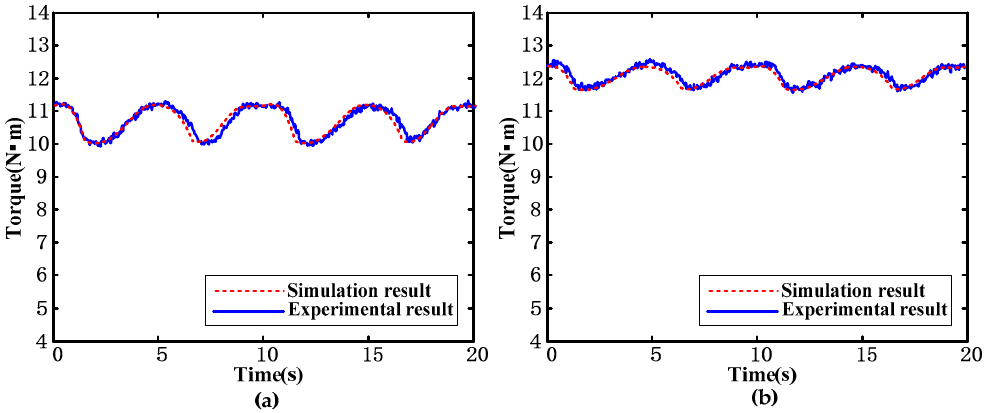
Figure 14. The output torque experiment contrast curves of the electromotor under different pressures. ( a ) 6.0 MPa; ( b ) 10.0 MPa.